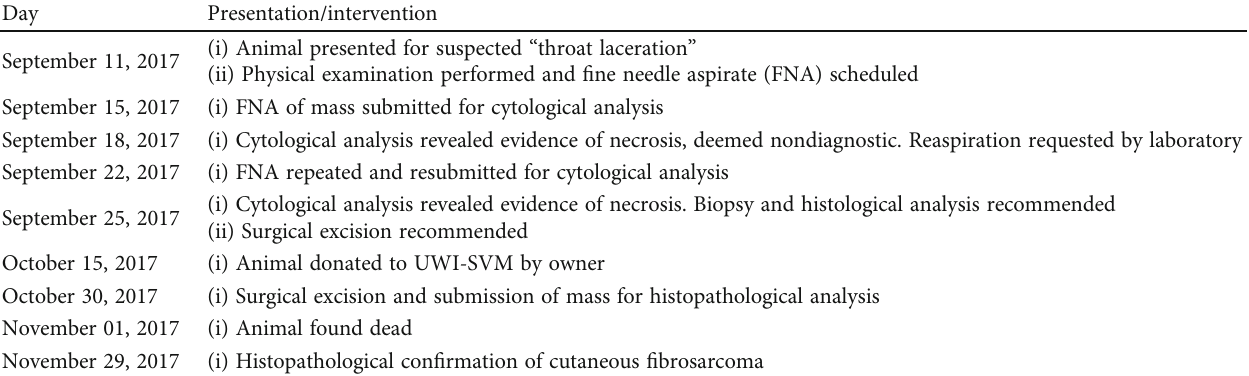
Figure 4: Histological features of mass excised from the gular region of a saddled bichir ( Polypterus endlicheri endlicheri ). (a) Unencapsulated mass in the deep dermis with streams and bundles. Hematoxylin and eosin, bar = 500 μ m . (b) The mass is composed of streams and bundles of spindled cells. Hematoxylin and eosin, bar = 100 μ m . (c) Rare, small lymphocytic clusters are present around some vessels (arrow). Hematoxylin and eosin, bar = 100 μ m . Table 1: Timeline of the case of gular neoplasia in a saddled bichir ( Polypterus endlicheri endlicheri ).